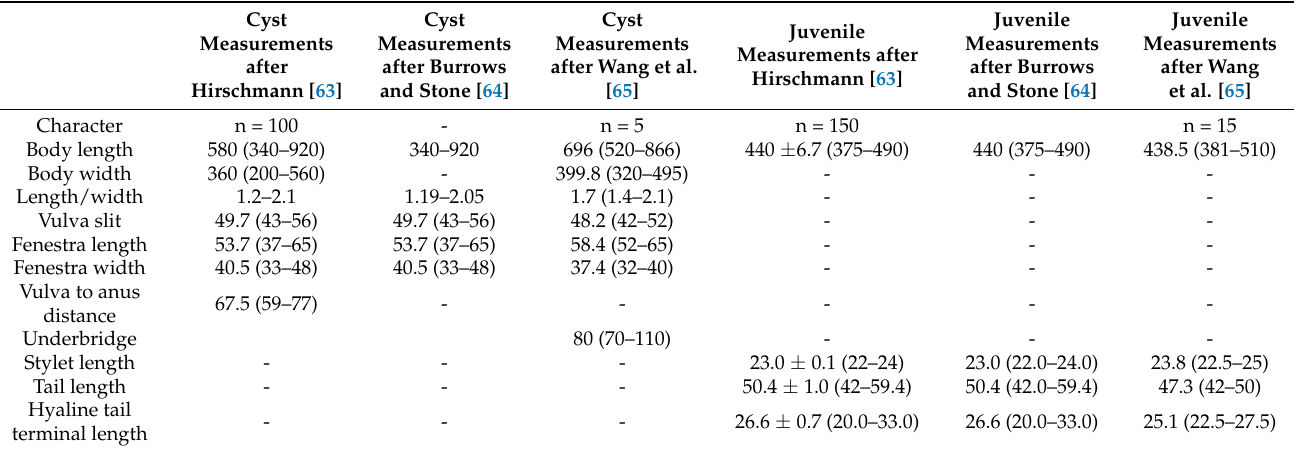
Table 5. Morphometrics of Heterodera glycines Ichinobe, 1952 cysts and juveniles. All measurements are given in µ